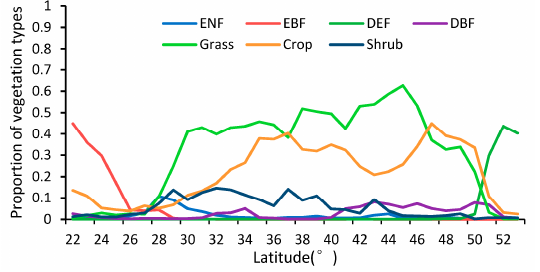
Figure 6. Proportion of vegetation in different latitudinal bands.